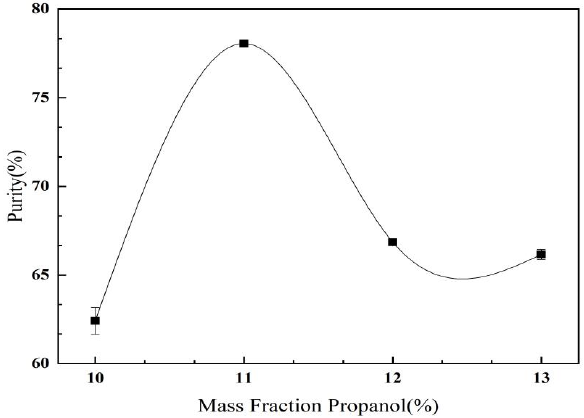
Figure 9. Effect of propanol mass fraction on the purity of C. oleifera saponins aqueous two ‐ phase